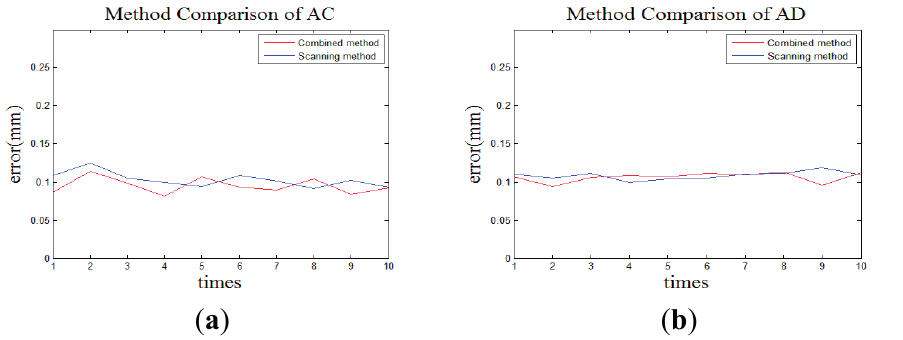
Figure 9. The error comparison by two methods: ( a ) The measured object is AC; ( b ) The measured object is